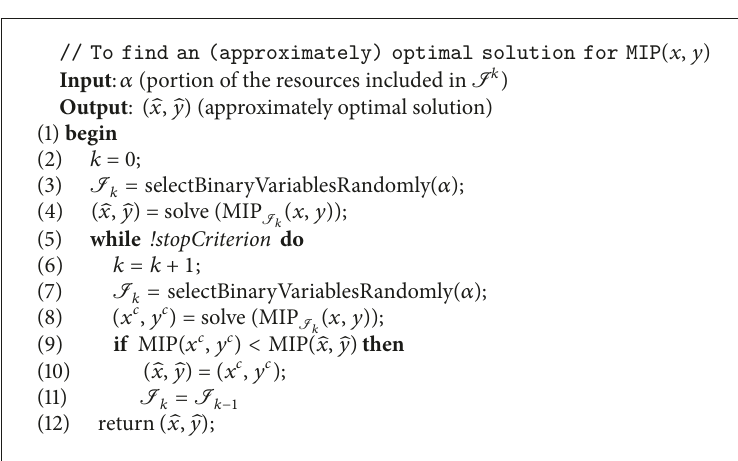
Algorithm 4: Matheuristic method using the blind